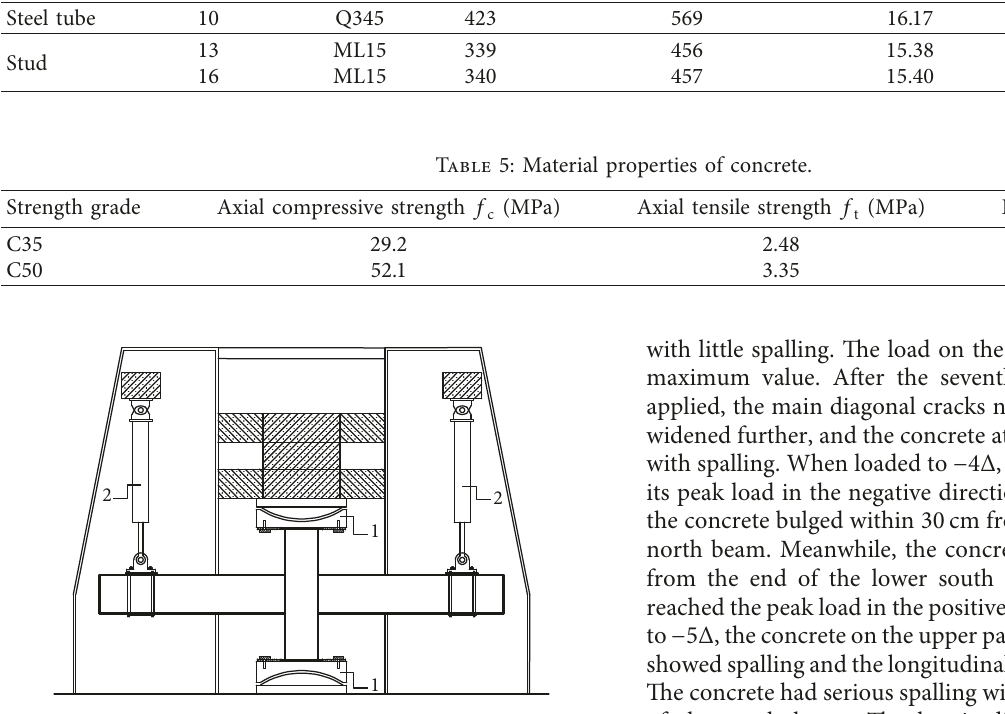
Figure 4: Test setup: (1) spherical hinge and (2) vertical actuator.